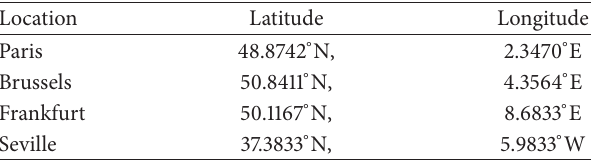
Table 1: Selected locations.